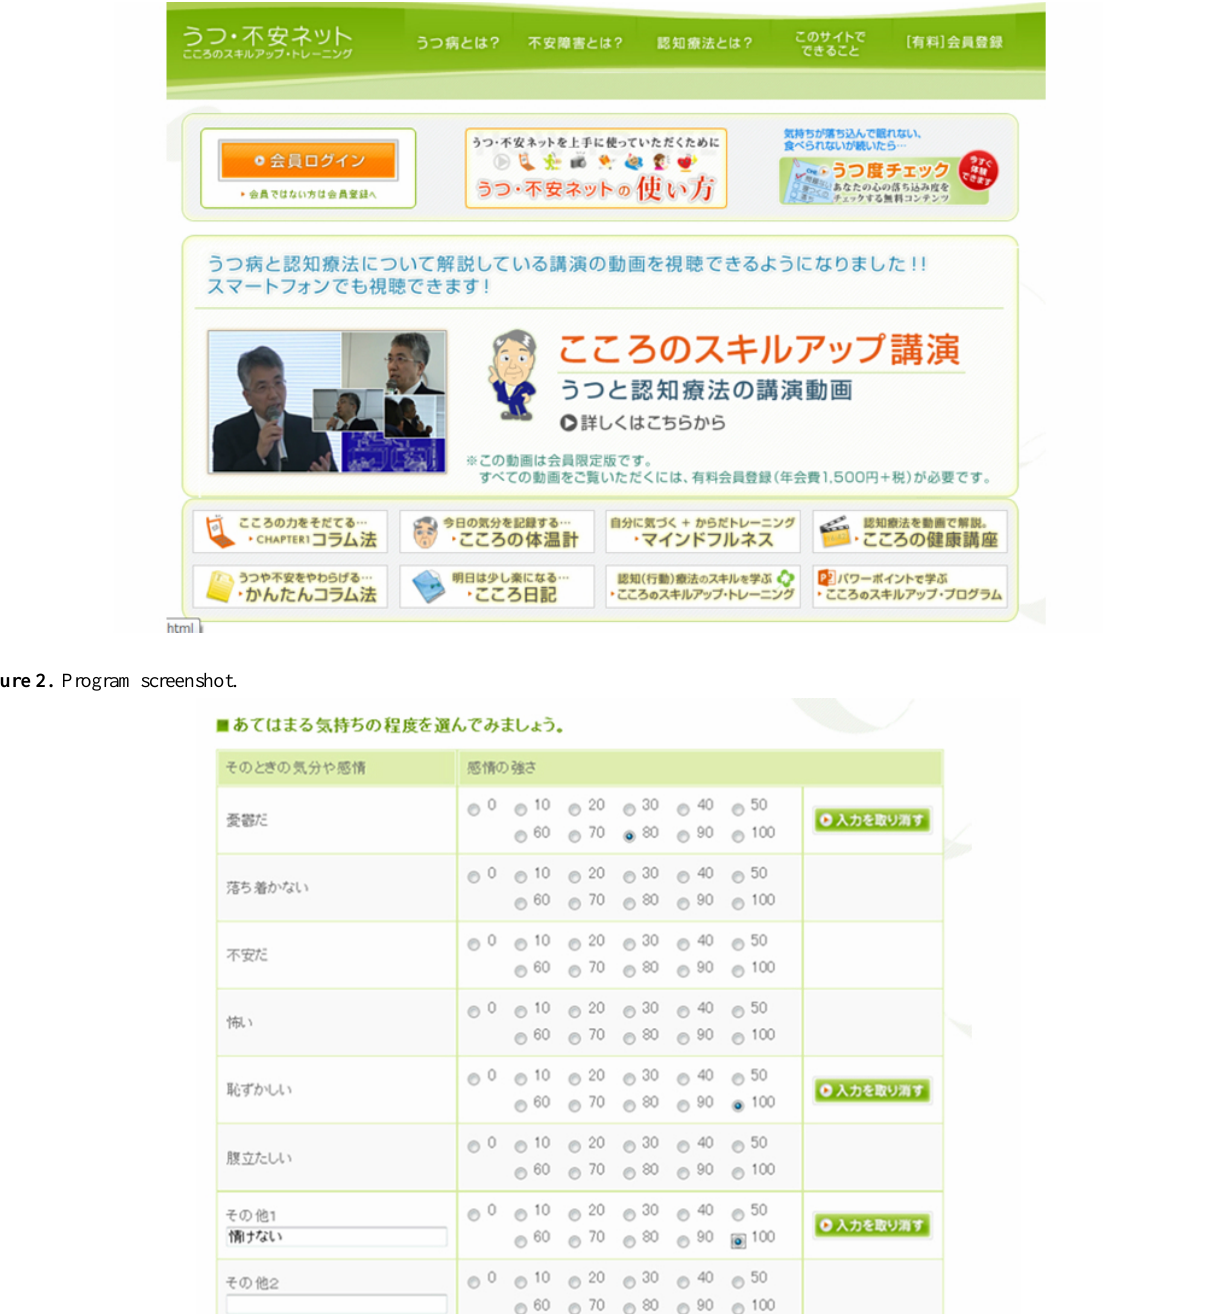
Figure 1. Program screenshot.